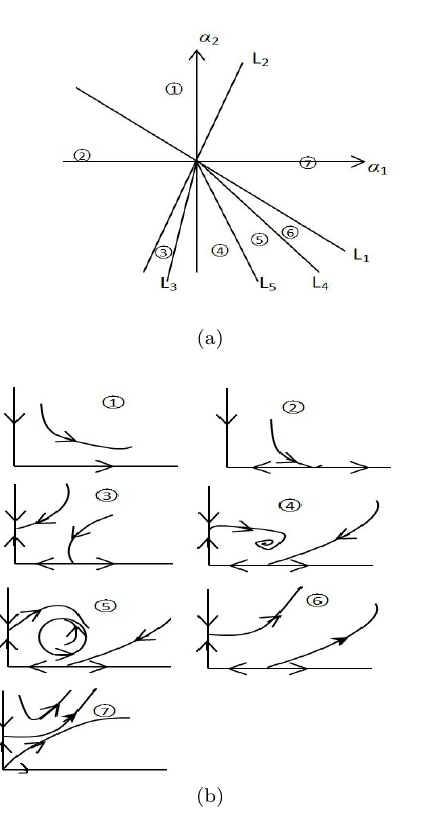
Figure 4. The bifurcation diagram and phase portraits for (5.1) near ( α 1 ,α 2 ) = (0 ,